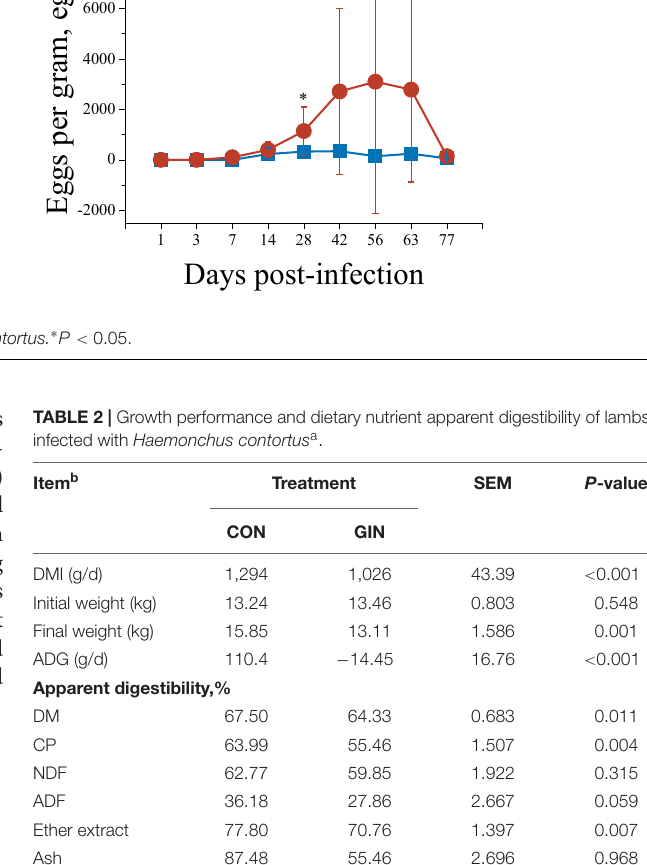
( Figure 2 ). Plasma concentrations of essential amino acids (EAA) decreased after 42 days post-infection but did not reach significance ( P > 0.05). Similarly, there was no difference between CON and GIN ( P > 0.05) in concentrations of non-essential amino acids (NEAA). However, concentrations of aspartic acid (Asp) ( P = 0.003) and glutamine acid (Glu) ( P = 0.008) in